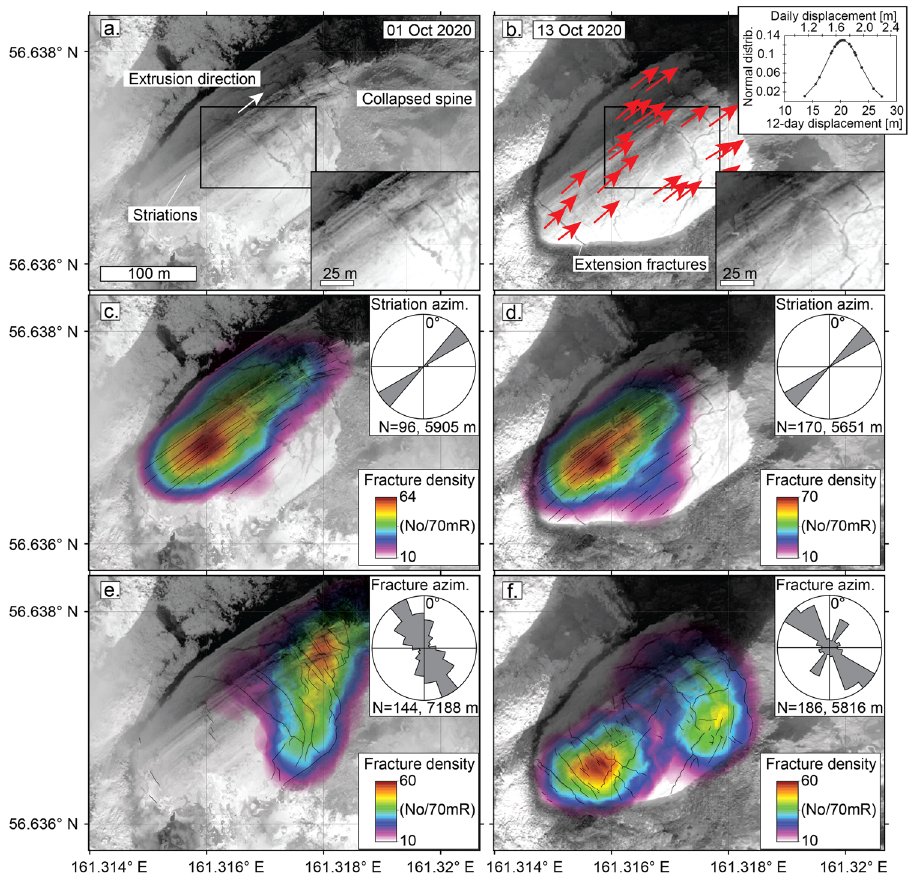
Fig. 6 Displacement and fracture analysis. The 2020 Shiveluch whaleback spine, shown for two satellite image datasets (October 1 and 13, 2020). a Striations have developed in a NE-SE direction, sub-parallel to the N54°E azimuthal elongation direction of the spine. Fractures show opening perpendicular to the elongation axis. b The following satellite data (12 days later) reveals similar striations, but fractures have been displaced to the NE by a cumulative mean of 20.4m, as determined by pixel tracking. c , d Striation density analysis reveals clustering at the lower SE fl ank of the whaleback, with orientation NE-SW shown by the 48 polyline features weighted by length to 2940 elements, the mean directions at 56° in rose plot, and an angular deviation of only 5.1°. e , f Fracture density concentrates near the spine collapse region at higher elevations (above 2660 m). Statistics and rose plots show the 72 features weighted by length to 1649 elements, the mean directions at 132° with an angular deviation of 59.6°. Pleiades TriStereo data was analyzed in ArcMap vs. 10.8.1., rose diagrams generated using Polar Plots and Circular Statistics 60